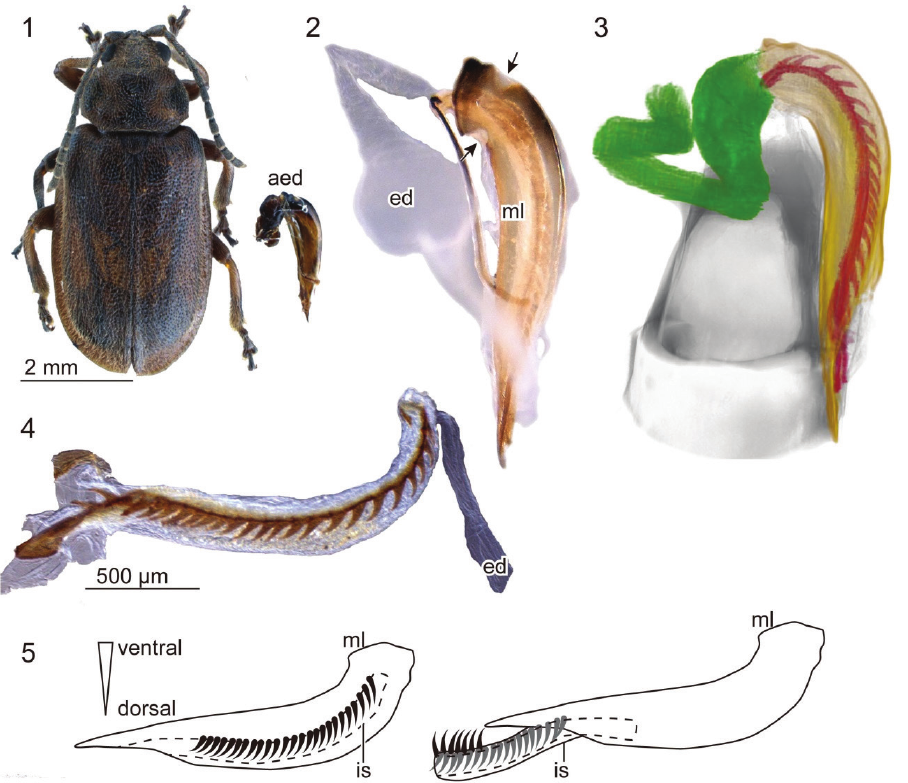
Figures 1–5. Aedeagus of Pyrrhalta maculicollis in the lateral view 1 relative size of the aedeagus com- pared to body size 2 the aedeagus and a part of the ejaculatory duct, muscles completely macerated. Two arrows point to the membranous areas of the median lobe 3 a micro CT scanned and segmented aedeagus and a part of the ejaculatory duct. The green structure represents the part of the ejaculatory duct with well–developed circular muscles, the yellow one represents the median lobe, and the red ones represent spines on the internal sac 4 the internal sac at rest with a part of the ejaculatory duct (ed) 5 schemes of the aedeagus at rest (left) and with partly evaginated internal sac during copulation (right). Abbreviations: aed, aedeagus; ed, ejaculatory duct; is, internal sac; ml, median